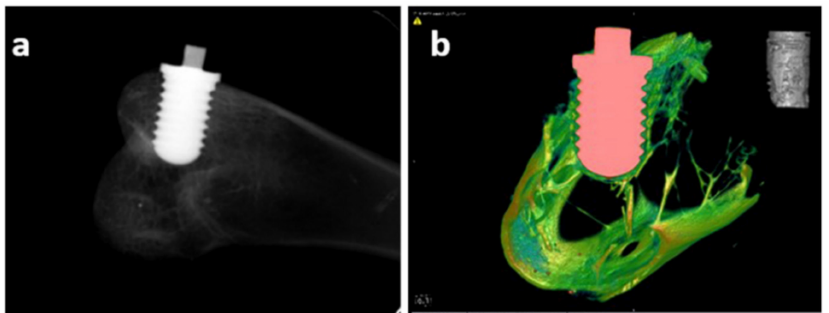
Figure 13. X-ray film ( a ) and reconstructed micro-CT image ( b ) from a model with an implant. The illustration in the upper-right corner of image ( b ) is the reconstructed image of the bone within the region of interest, adapted from [10], with permission from Elsevier,